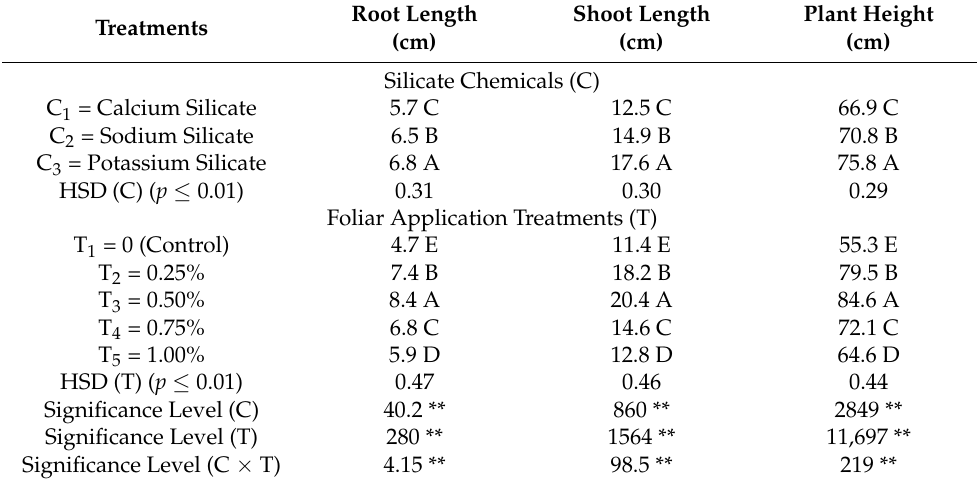
Table 1. Effect of silicate chemicals, with various doses of foliar applications, on the growth attributes of rice grown in Cd-contaminated soil.